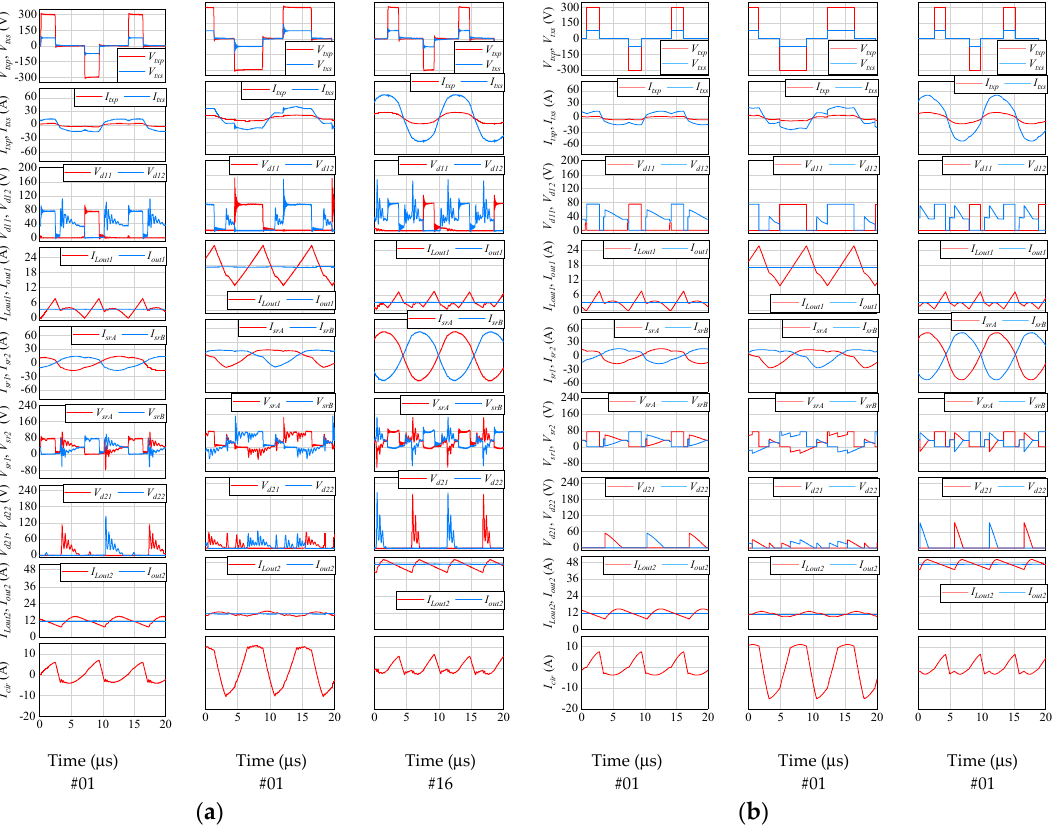
Figure 14. Results of D tx for each measurement point: ( a ) Experimental results; ( b ) Simulation results.